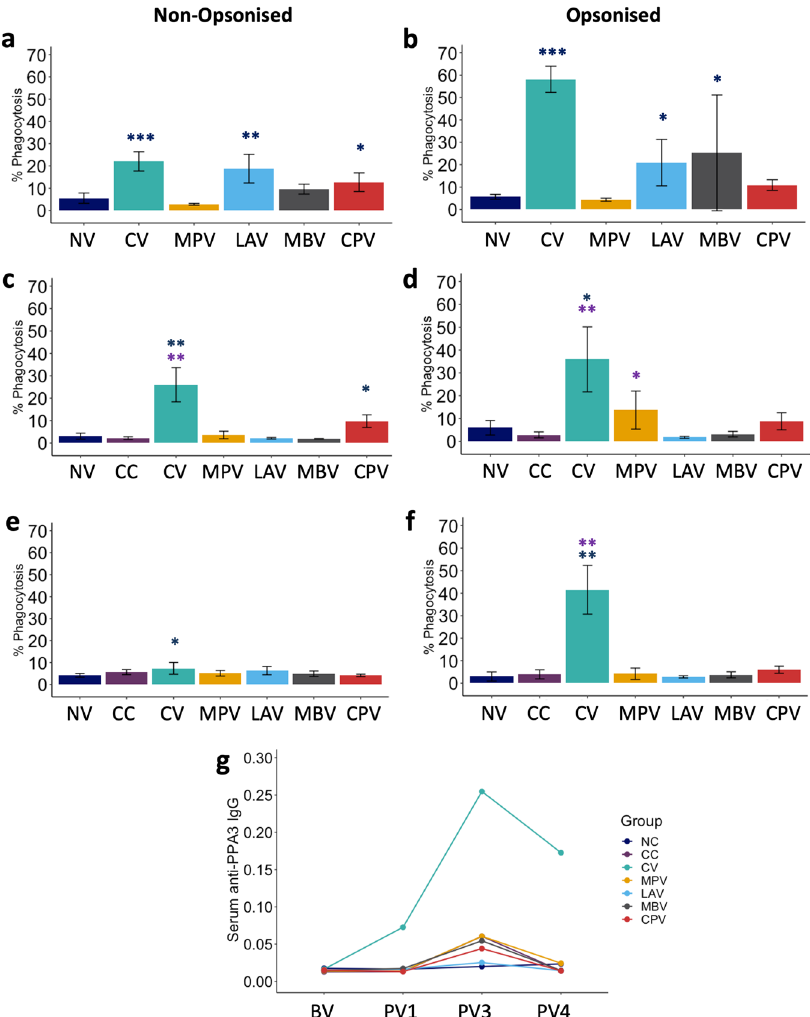
Fig. 2 PMN phagocytosis levels. Phagocytosis against a , c , e non-opsonized and b , d , f opsonized Mycobacterium avium subsp. paratuberculosis (Map)-GFP at a , b PV1 (1 month after fi rst dose vaccination), c , d PV3 (2 months after challenge) and e , f PV4 (3 months after challenge) of non-vaccinated and non-challenged (NV: NC + CC at BV and PV1, mean of n = 9); non-challenged (NC), non-vaccinated and challenged (CC), commercial Map inactivated vaccine (CV), killed Map strain oral vaccine (MPV), live attenuated vaccine (LAV), killed Mycobacterium bovis vaccine (MBV) and killed Corynebacterium pseudotuberculosis vaccine (CPV). g Serum anti-PPA3 IgG levels. All values for vaccinated groups were means of n = 5 with error bars representing standard deviation and Kruskal – Wallis with Dunn ’ s post-hoc test was applied. Blue asterisks represent signi fi cant differences compared to the NC group, purple asterisks compared to the CC group and signi fi cation levels are *<0.05, **<0.01,